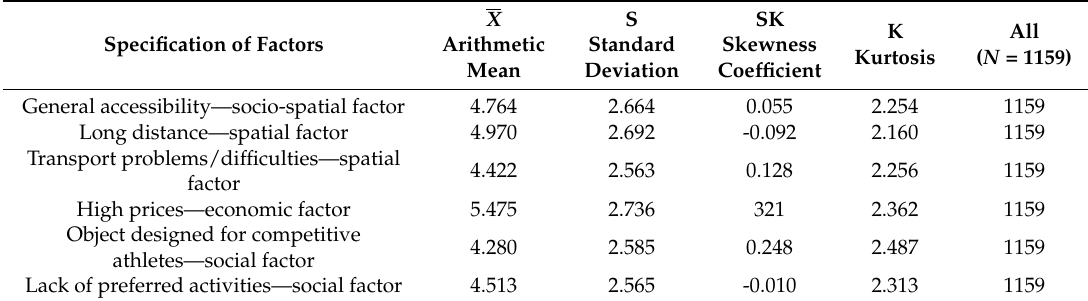
Table 4. Statistical characteristics of factors restricting the possibility of using sports and recreation facilities, based on the opinions of service recipients.